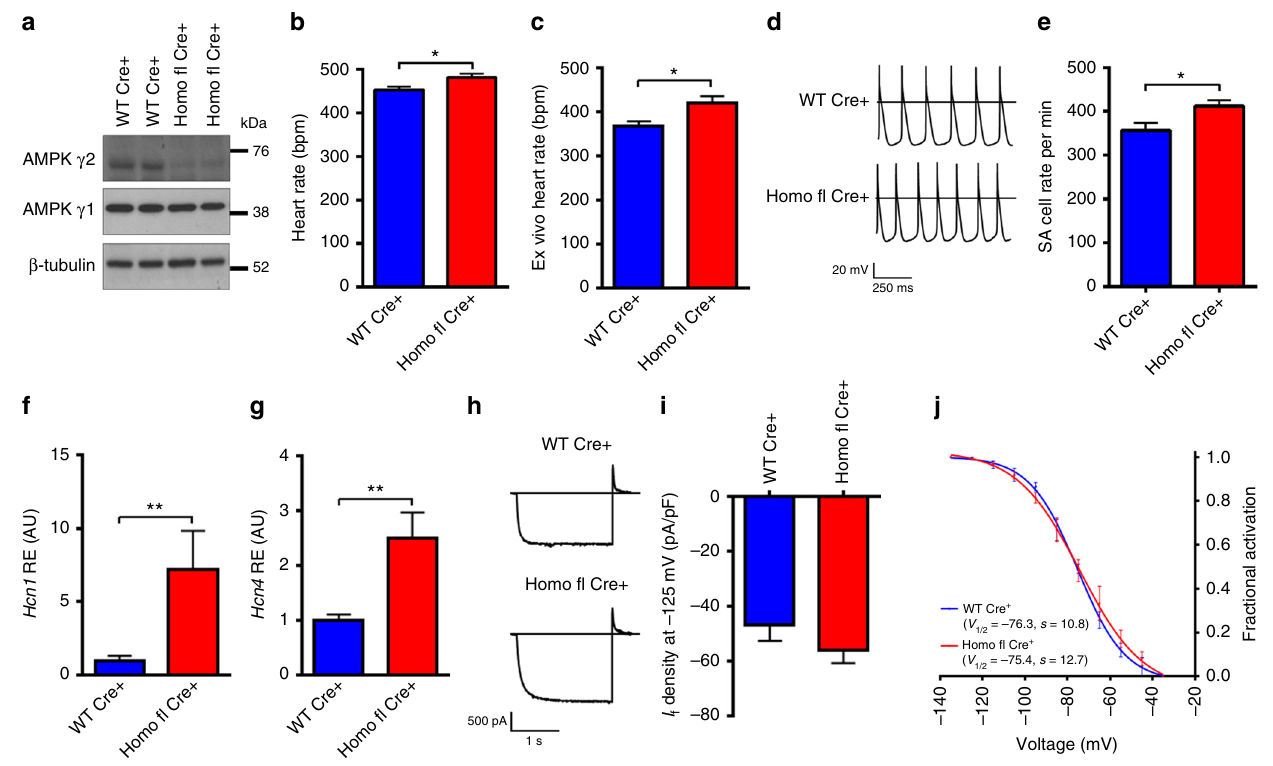
Fig. 7 Loss of γ 2 AMPK increases resting heart rate and SA cell automaticity. a Cardiac western blot for γ AMPK isoforms in Sox2cre-driven γ 2 knockout mice (Homo fl Cre+) and WT Sox2cre carrying controls (WT Cre+). b HR of Homo fl Cre+ and WT Cre+ mice under anesthesia ( n = 7 – 12). c HR during